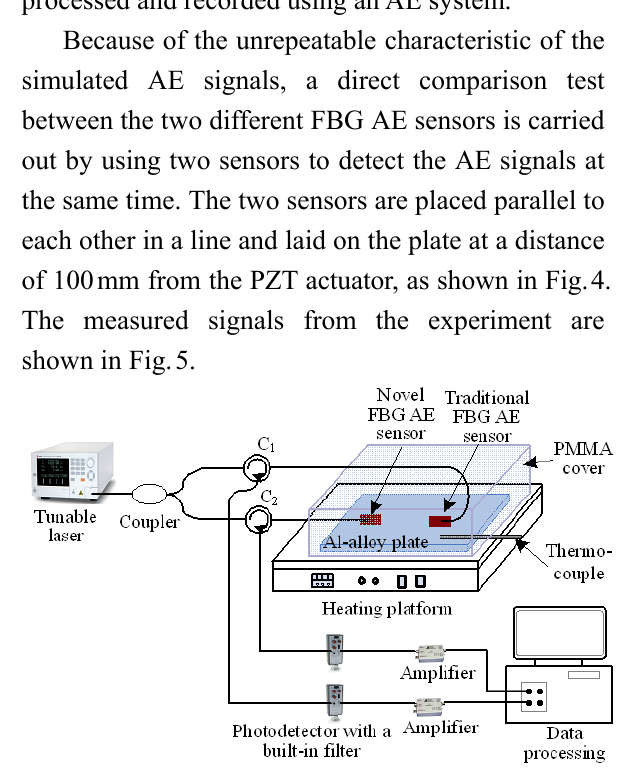
Fig. 4 Schematic of the experimental